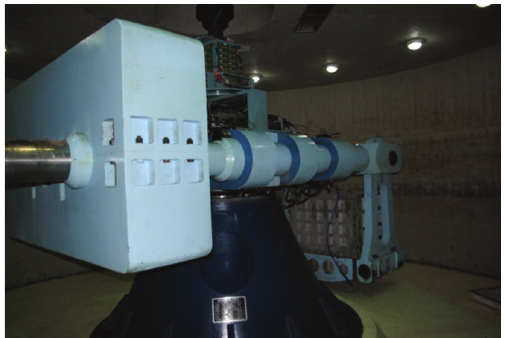
Figure 3: The geotechnical centrifuge of Tongji University.